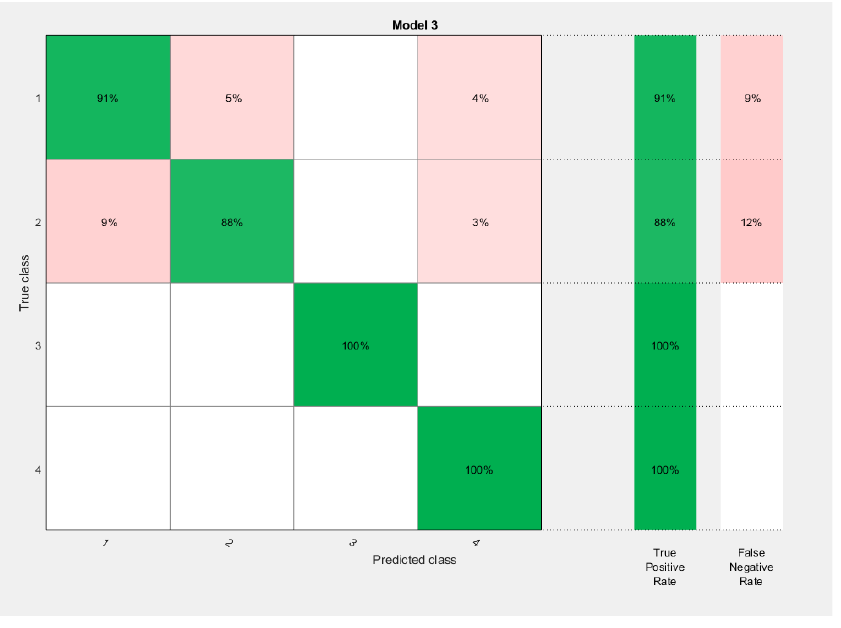
Figure 6. Confusion matrix for ANN-classifier.